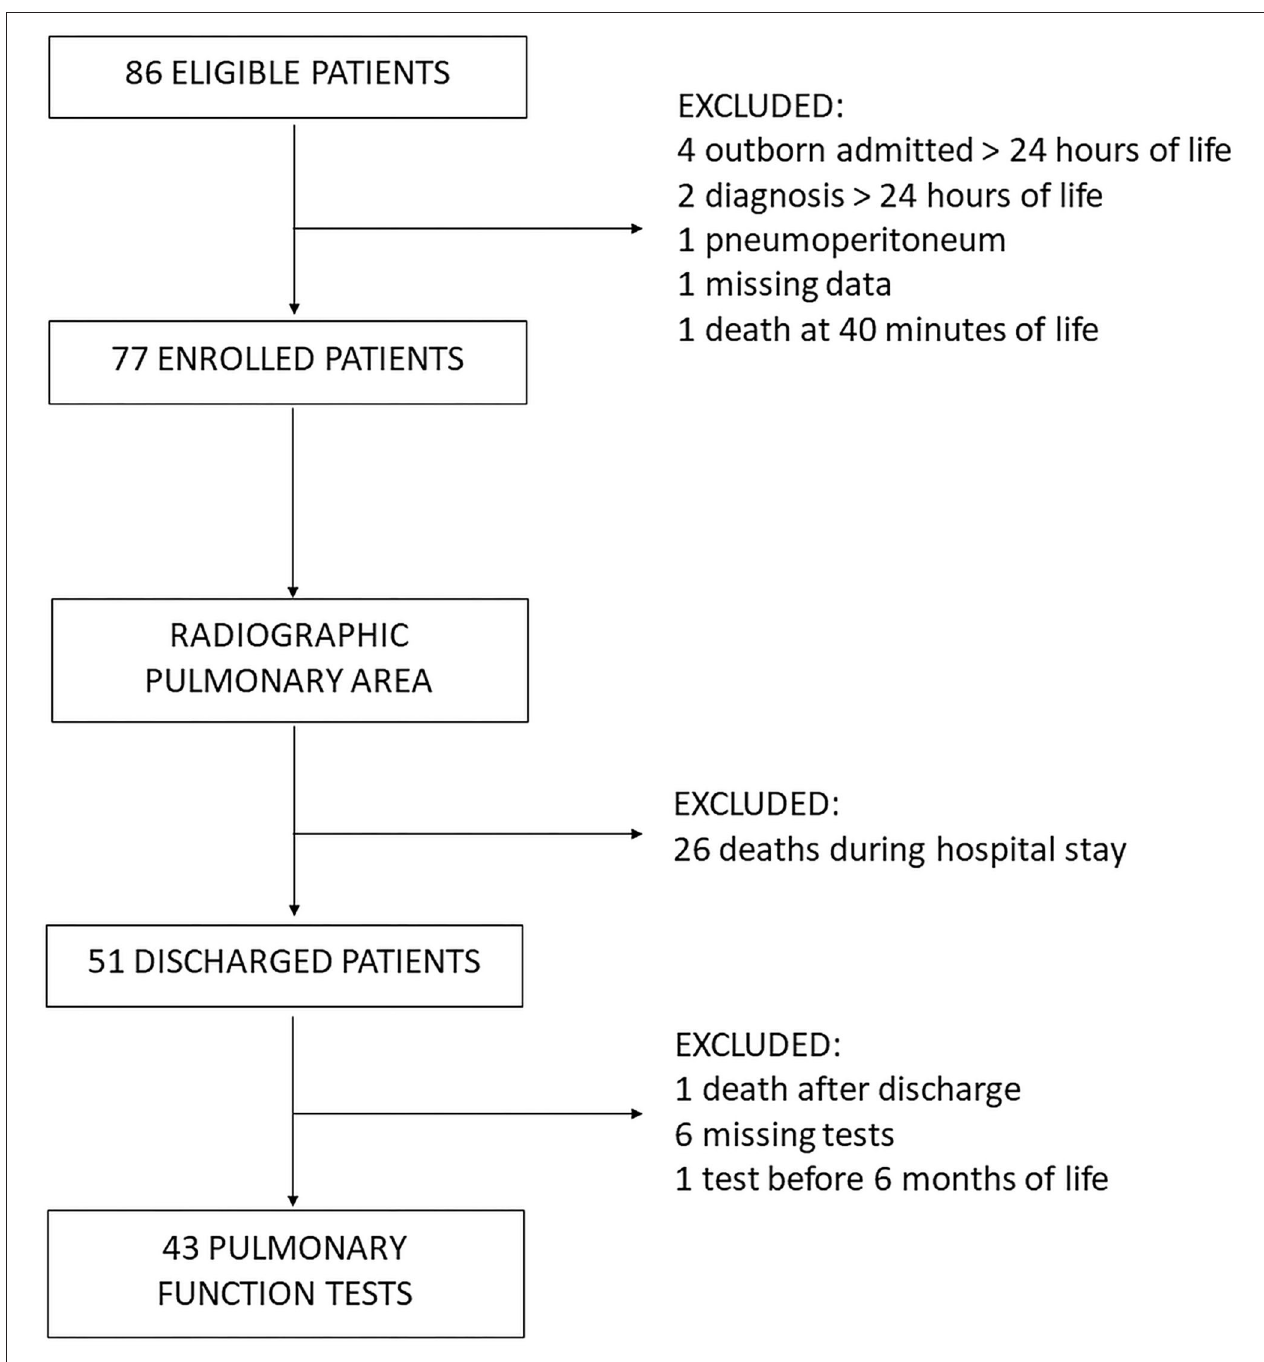
FIGURE 2 | Study Flowchart.